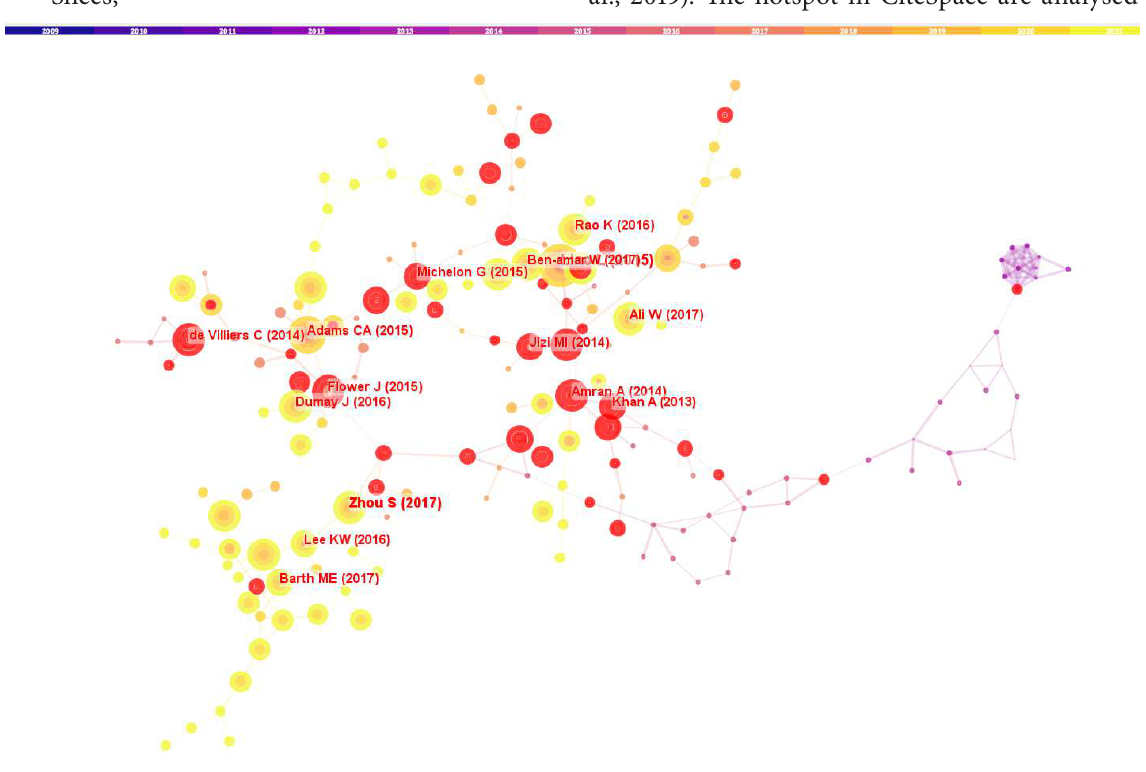
Figure 6. Co-cited article